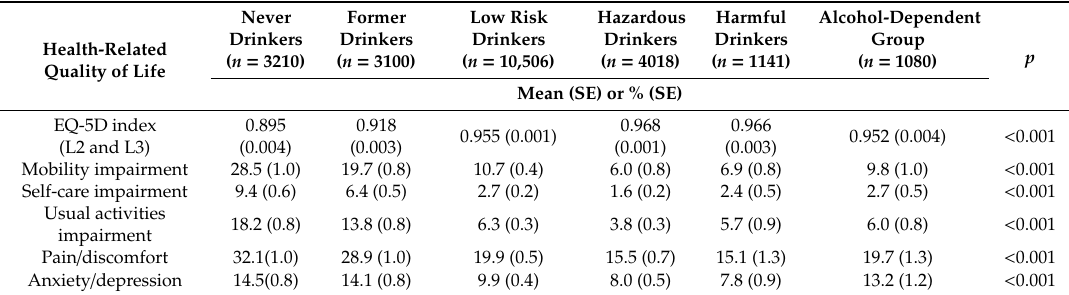
Table A1. D and mean values of the EQ-5D index in groups of di ff erent alcohol drinking patterns.